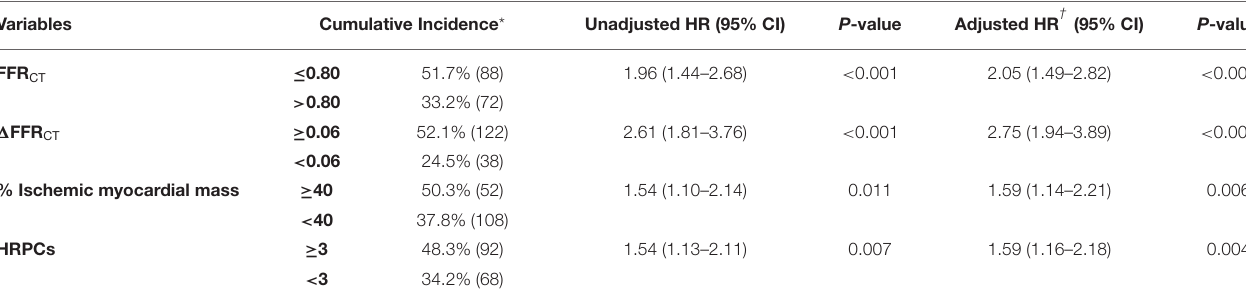
TABLE 3 | Cumulative incidence of subsequent coronary events according to hemodynamic parameters and HRPCs. Variables Cumulative Incidence